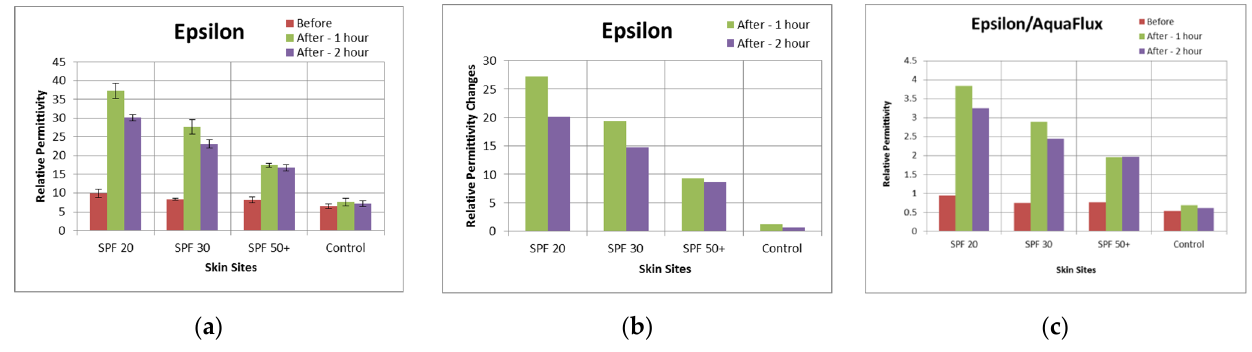
Figure 7. Epsilon mean permittivity readouts of the four skin sites before and after sunscreen application ( a ), the corresponding change in permittivity at each site ( b ), and the ratio of AquaFlux values over Epsilon values ( c ).